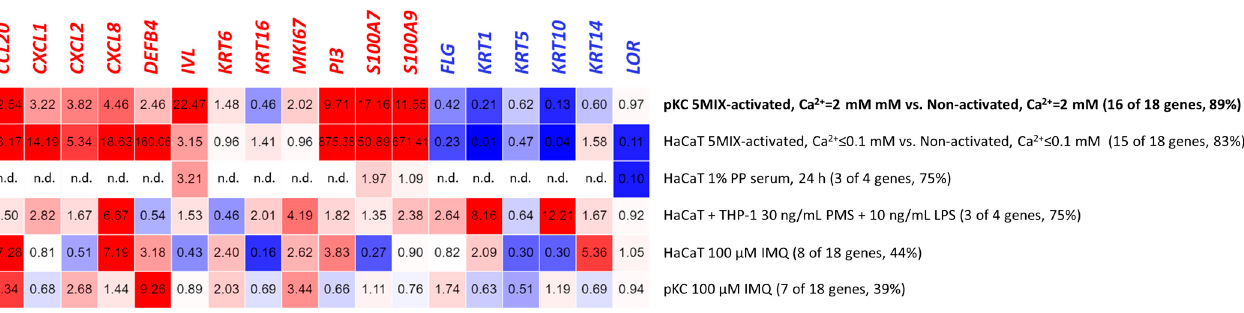
Figure 3. Portraits of all tested in vitro cell models and the model best mimicking the Ps phenotype. Gene names in red are upregulated and in blue are downregulated, according to the literature reports as stated in Table 1. N.d.—no data available.